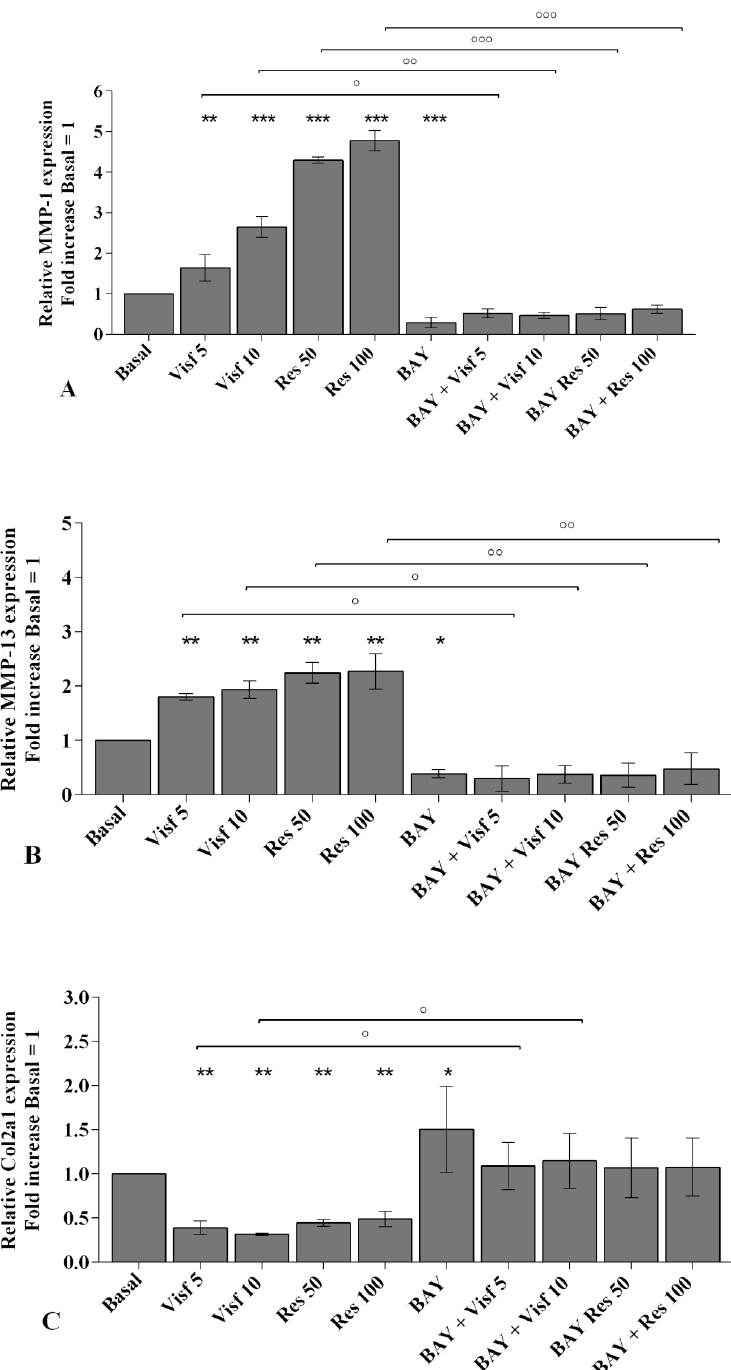
Figure 11. Expression levels metalloproteinases ( MMP )- 1 ( A ), MMP-13 ( B ), collagen type II ( Col2a1 ) ( C ) by real-time PCR. Human osteoarthritic (OA) synovial fibroblasts were evaluated at basal condition, after 2 h pre-incubation with a specific nuclear factor (NF)- κ B inhibitor (BAY 11-7082, IKK α / β , 1 µ M) and after 24 h of stimulus with visfatin (5 and 10 µ g / mL) and resistin (50 and 100 ng / mL). The gene expression was referenced to the ratio of the value of interest and the value of basal condition (basal, cells without treatment) reported equal to 1. Data were expressed as mean ± SD of triplicate values. * p < 0.05, ** p < 0.01, *** p < 0.001 versus basal condition. ◦ p < 0.05, ◦◦ p < 0.01, ◦◦◦ p < 0.001 versus BAY. BAY = BAY 11-7082, Visf = visfatin, Res =